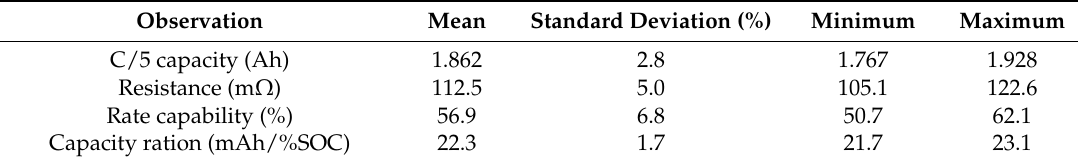
Table 2. Summary of the observed variations after 1000